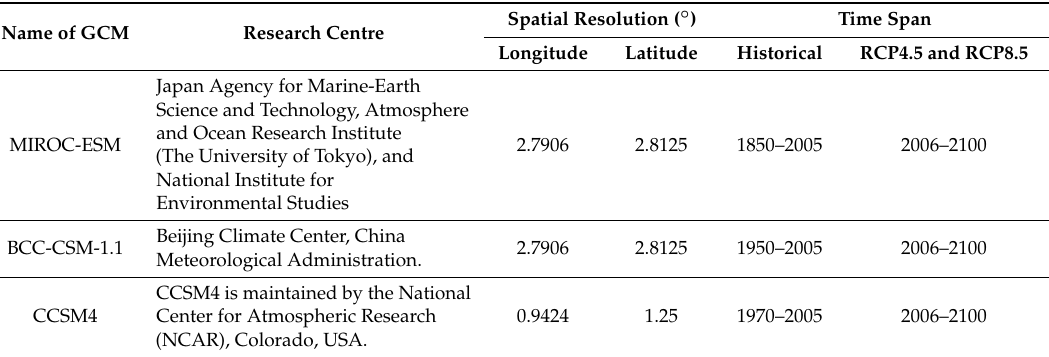
Table 2. Detail climate models used to project climate change scenarios in the study basin. Name of